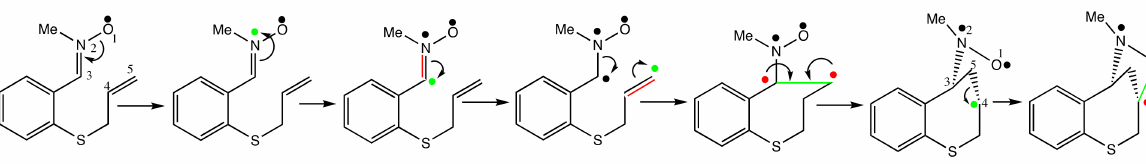
Scheme 7. Curly arrow representations of the main electron density flows of the reaction from 5 to 7 .